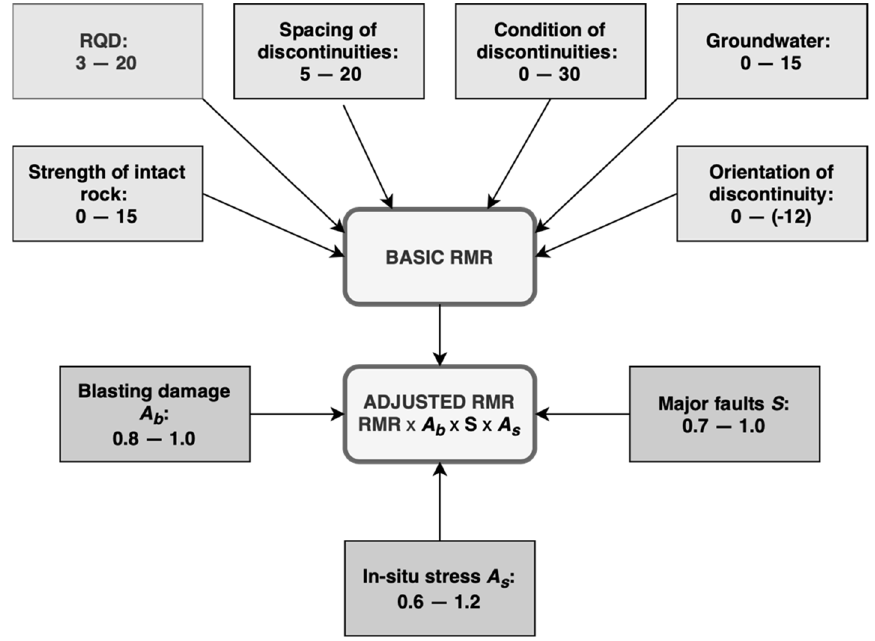
Figure 2. Flow chart for calculation of RMR value; redrawn from [31]. Table 1. Correlation between rock mass rating and support; from [28]. RMR Rock